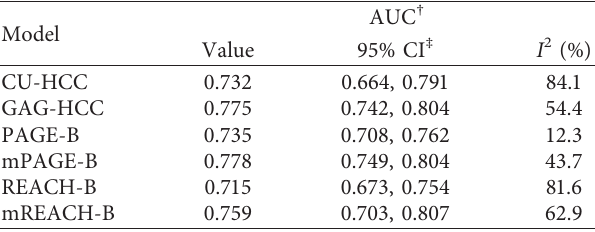
Table 2: The predictive performance of each model in CHB-related HCC